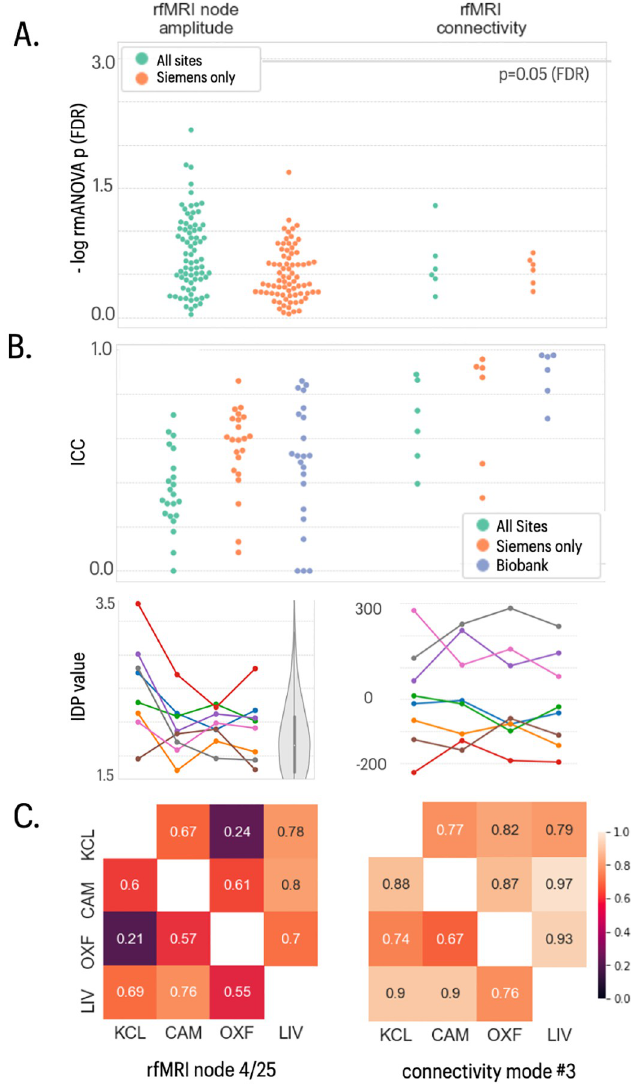
Fig 6. fMRI data quality and IDP summaries. The two columns show data on fMRI node amplitude and fMRI connectivity IDPs. Both represent IDPs derived from 25- and 100-node ICA-based parcellations. The fMRI connectivity IDPs represent 6 modes of variation across the functional connectivity network matrices derived from both parcellations. A ) Distribution of log-transformed P -values from repeated measures ANOVA testing for a site effect on the mean value of individual IDPs in each class; the solid horizontal line represents the P -value equivalent to FDR = 5%. Green dots represent IDPs fitted to the ANOVA model including data from all four sites; orange dots represent P -values for each IDP fitted to the ANOVA including only data from the three Siemens sites (Cambridge, Oxford, Liverpool). B) Swarm plots showing distribution of intra-class correlation coefficients (ICCs) for the same IDPs, estimated for each pair of all 4 sites (green points), for each pair of the three Siemens sites (orange points) and for comparable test-retest data drawn from the UKB cohort (blue points). Between-site reliability was generally high for all IDP classes compared to the UKB benchmark, whether or not GE data were included in the analysis. C) Each column represents finer-grained results for representative IDPs from each class of IDP: from left to right, fMRI node 4/ 25 (medial visual RSN) and summary connectivity mode #3 [15]. Top row , plots of each IDP for 8 subjects (coloured lines) scanned at each of 4 sites (x-axis labels); the grey violin plot indicates the distribution of the corresponding IDP in the UK Biobank reference dataset. Bottom row , correlations between each pair of sites for each IDP: upper triangle, Pearson’s correlations; lower triangle, Spearman’s